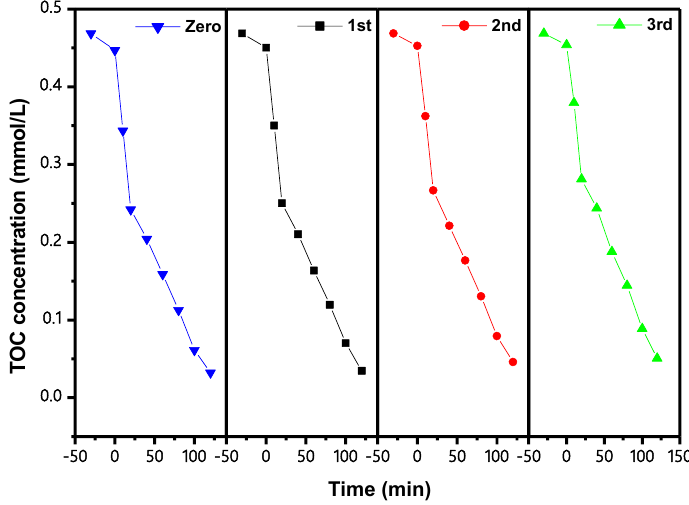
Figure 18. CCC of IC during PCD of IC in DW with IBHP under VLGI for TCDT.